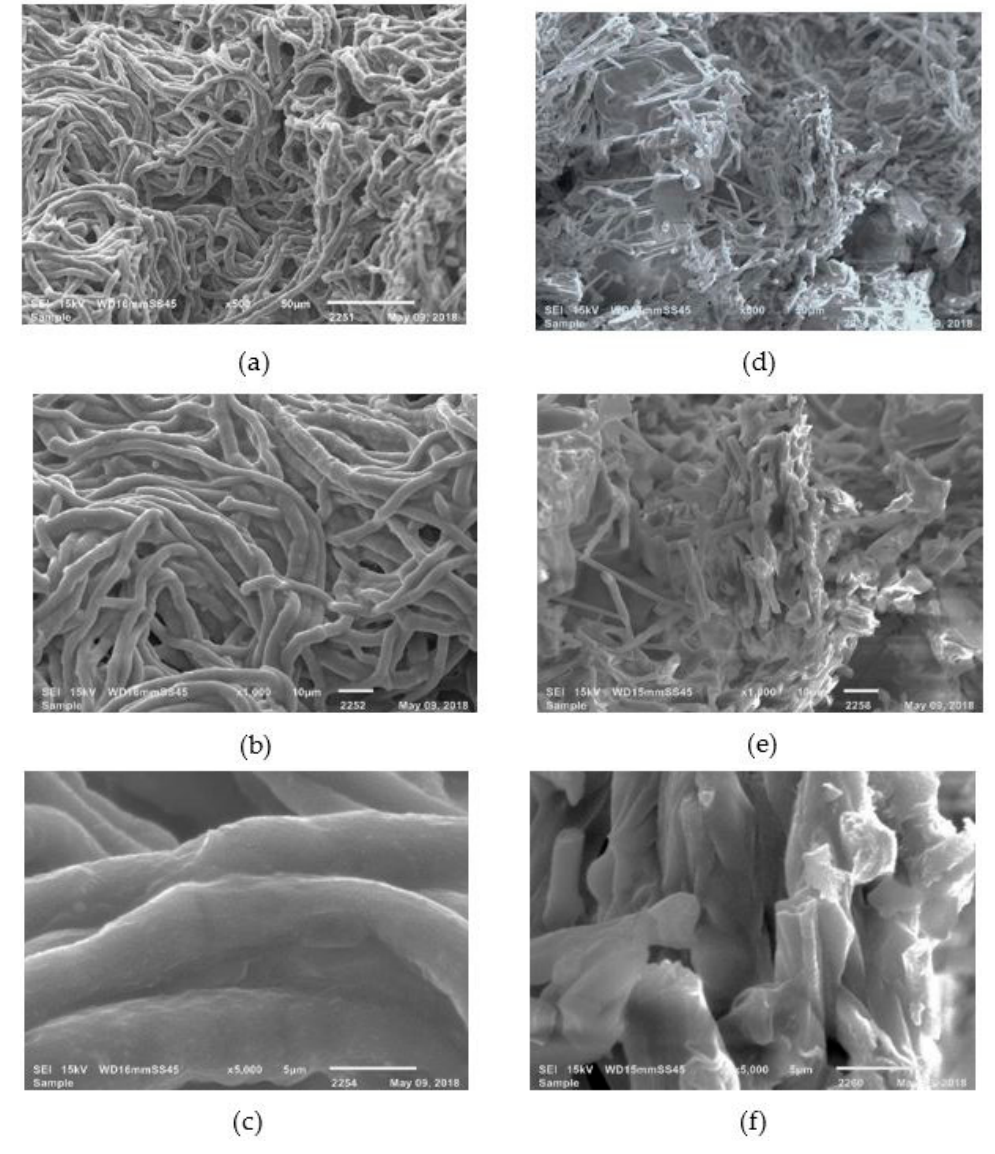
Figure 9. Scanning electron microscopy of Aspergillus flavus mycelium: ( a – c ) without treatment; ( d – f ) with nanostructured ZnO treatment at 1.25 mM. Profiles c,f are enlargements of b,e, respectively.